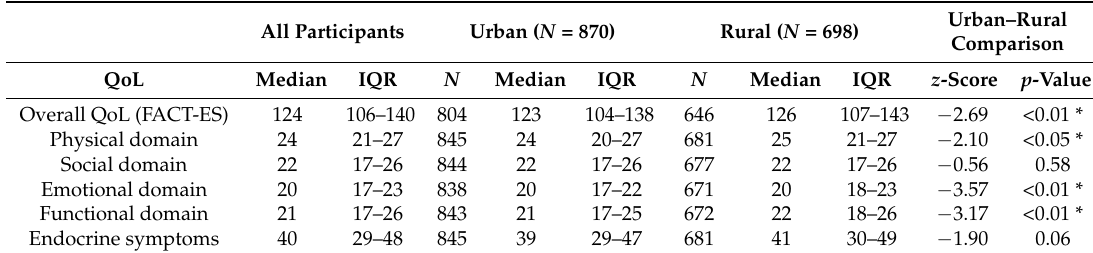
Table 2. Median (with IQRs) for overall QoL domain scores and endocrine symptoms for urban and rural survivors of stages I–III breast